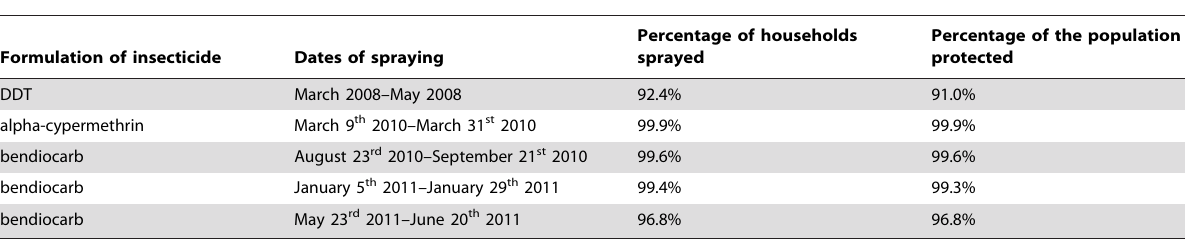
Table 1. Details of indoor residual insecticide spraying (IRS).